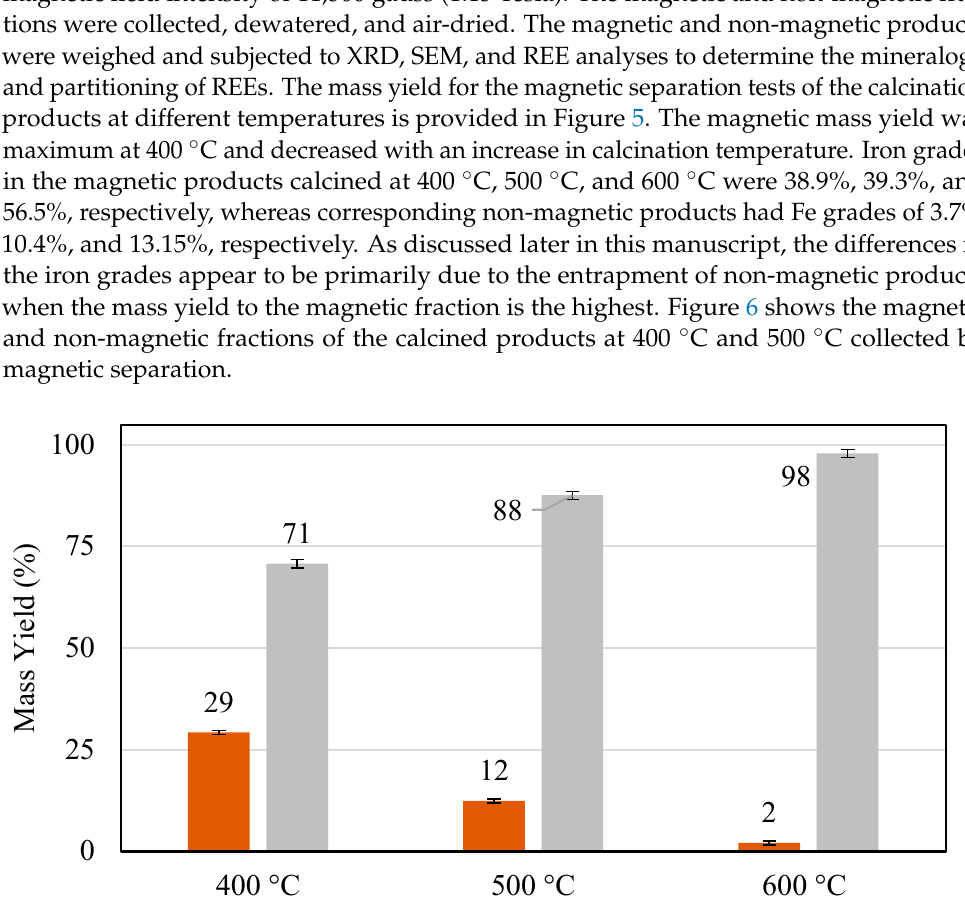
7 of 20 Figure 4. SEM images of various pyrite types found in the 2.20 SG sink fraction of the Baker seam coal course refuse material and EDX analysis showing the overall composition of these particles: ( a ) regular spherical shaped clusters, ( b ) composite mineral agglomerates, ( c ) large hexagonal crystals, and ( d ) small grain crystal clumps.